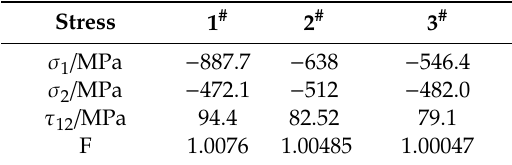
Table 4. Stress values and F values of monitoring points.